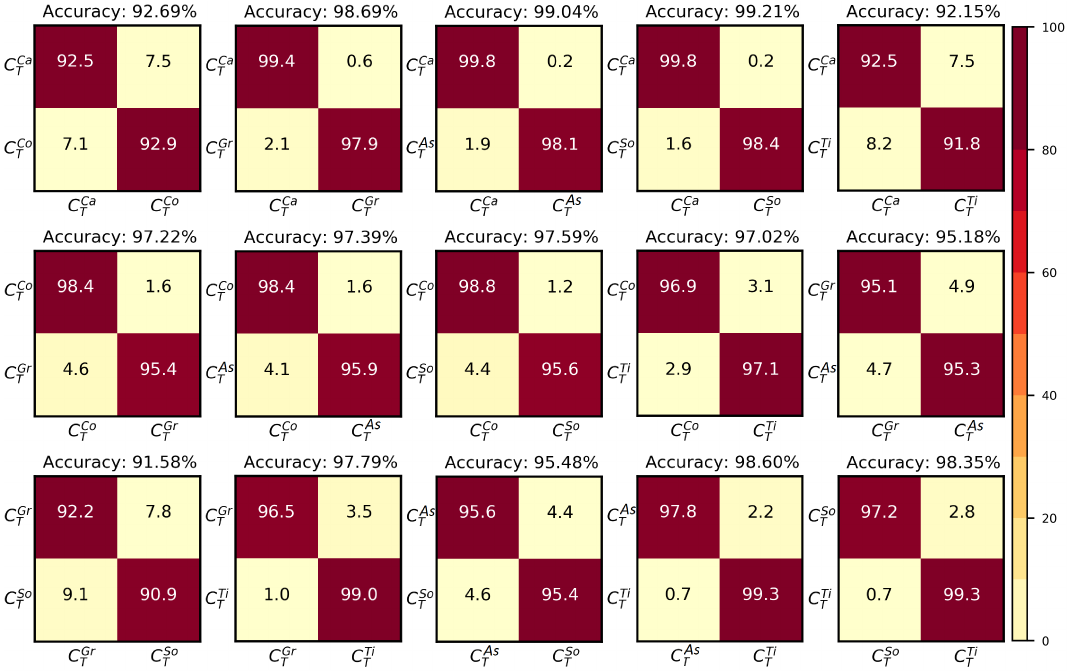
Figure 6. Confusion matrices of pair-wise classification with lower back sensor. All results were obtained with all features set (194 features) using SVM classifier. Classes: C Ca